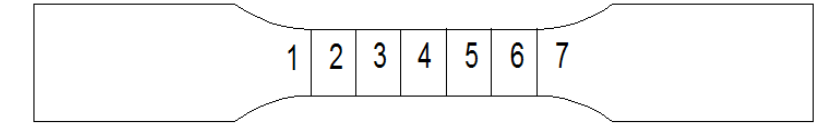
Figure 6. The exact location on the sample.